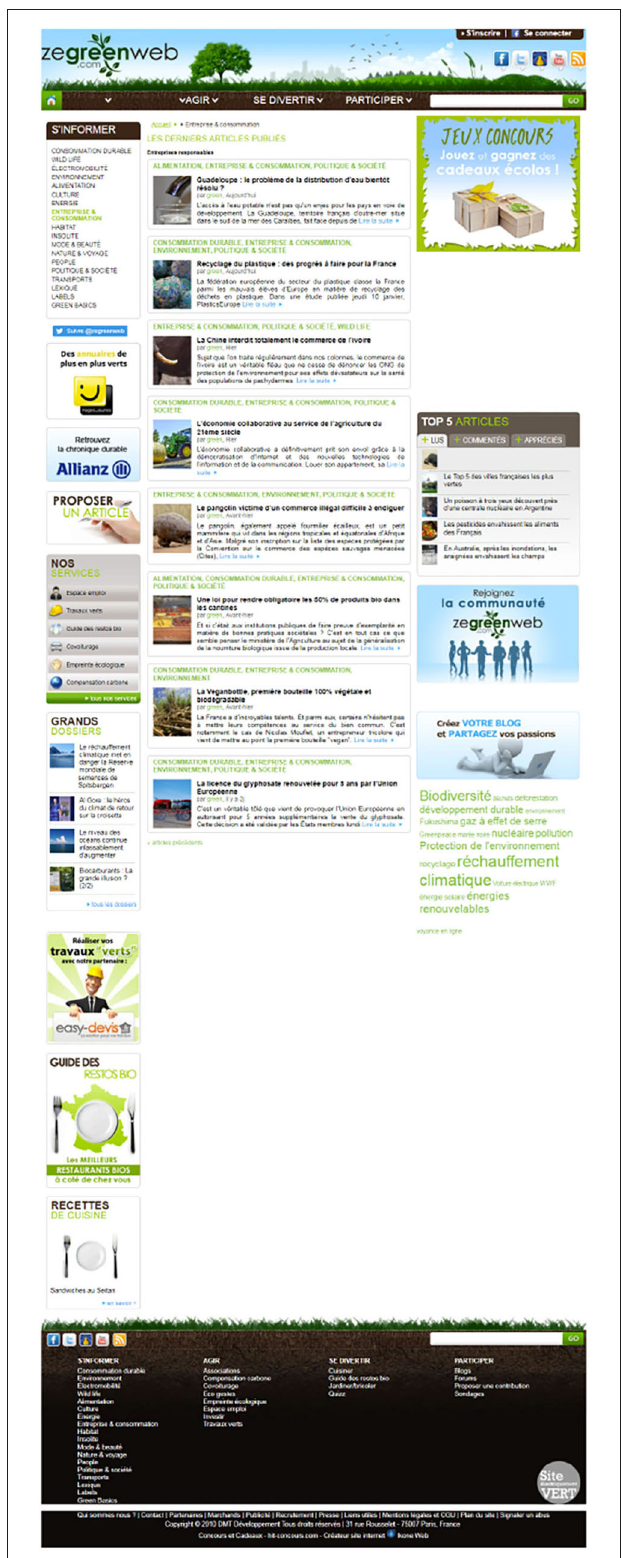
FIGURE 1 | Example of website displayed during the